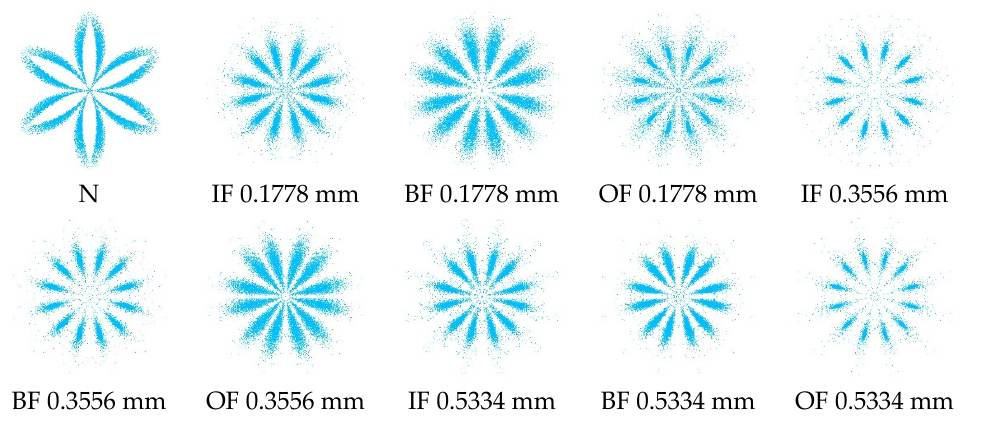
Figure 12. SDP images of 10 bearing states.